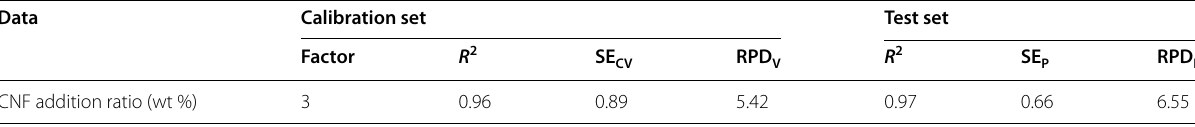
Factor: the optimum number of PLS factors, R 2 : coefficient of determination, SE CV : standard error of cross-validation, RPD V : ratio of performance to standard deviation of cross-validation, SE P : standard error of prediction, RPD P : ratio of performance to standard deviation of prediction